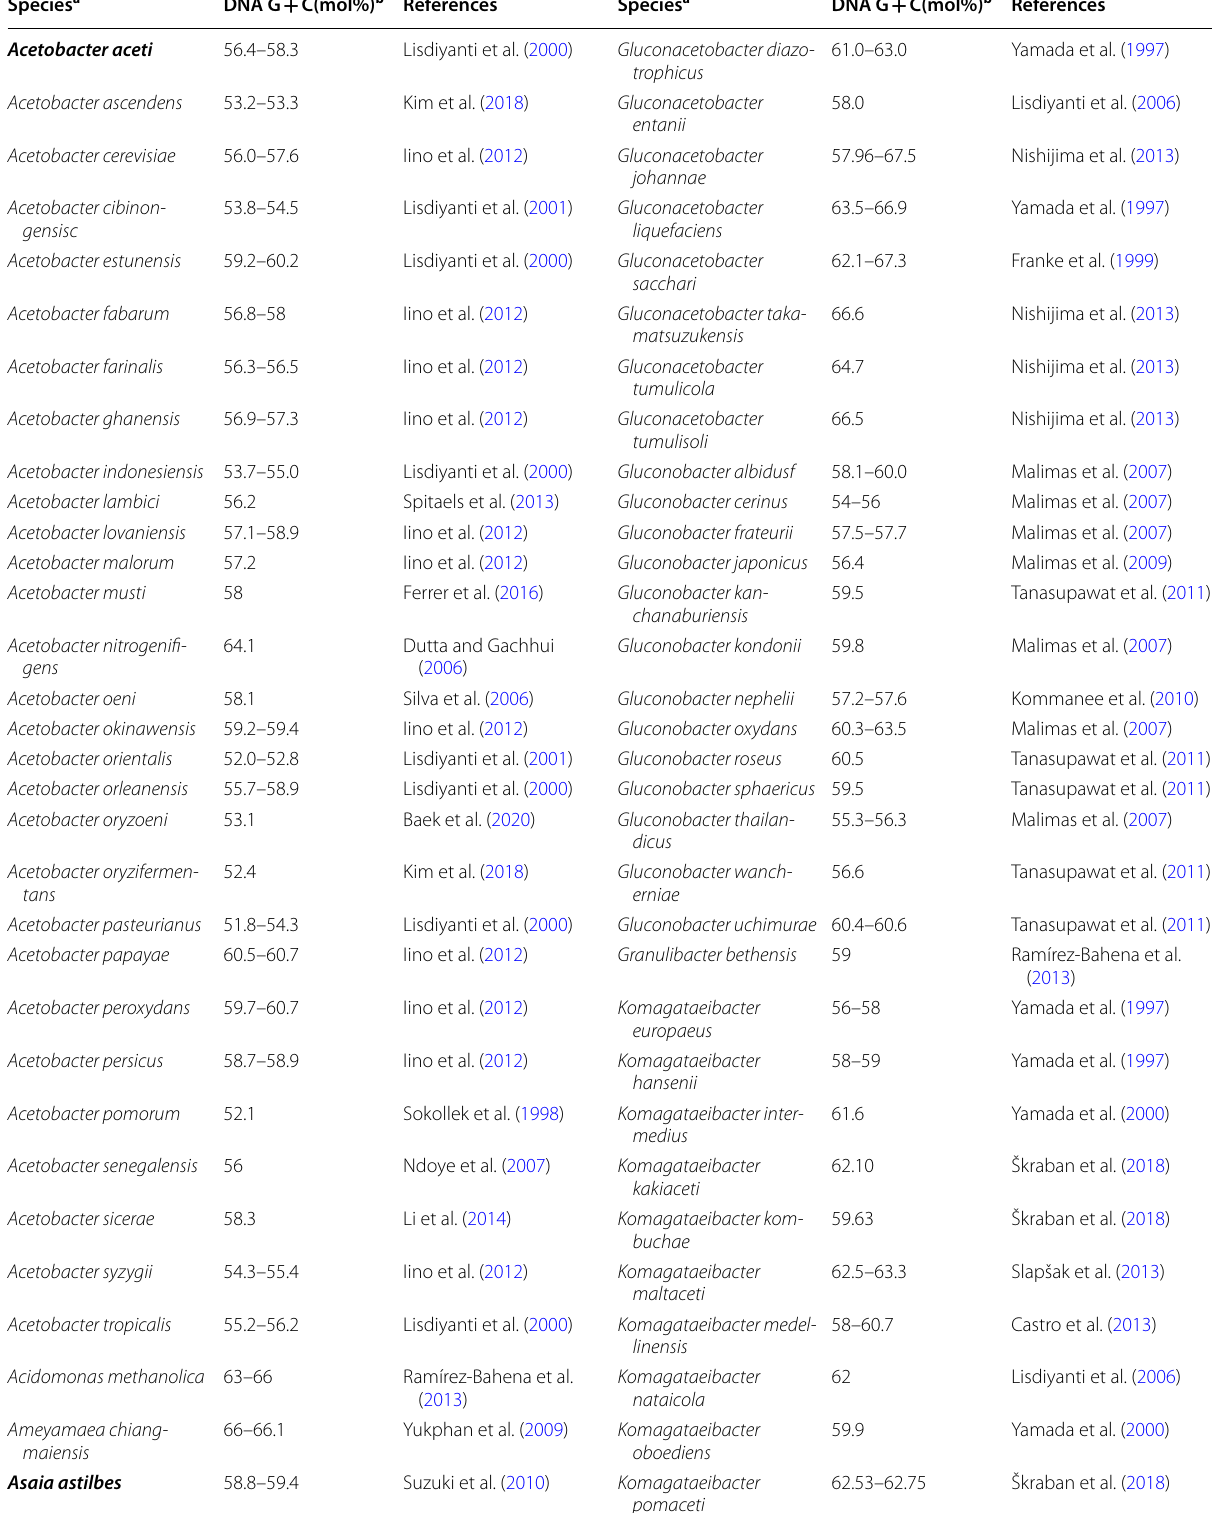
Table 1 Current classification of the Acetobacteraceae (19 genera, 92 species) Species